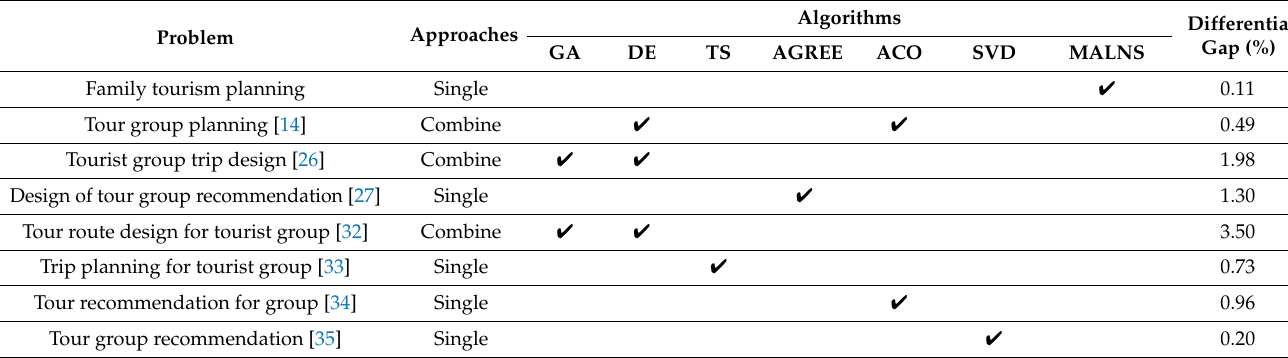
Table 6. Comparison of the differential gap percentage of other algorithms used in tour group problem.